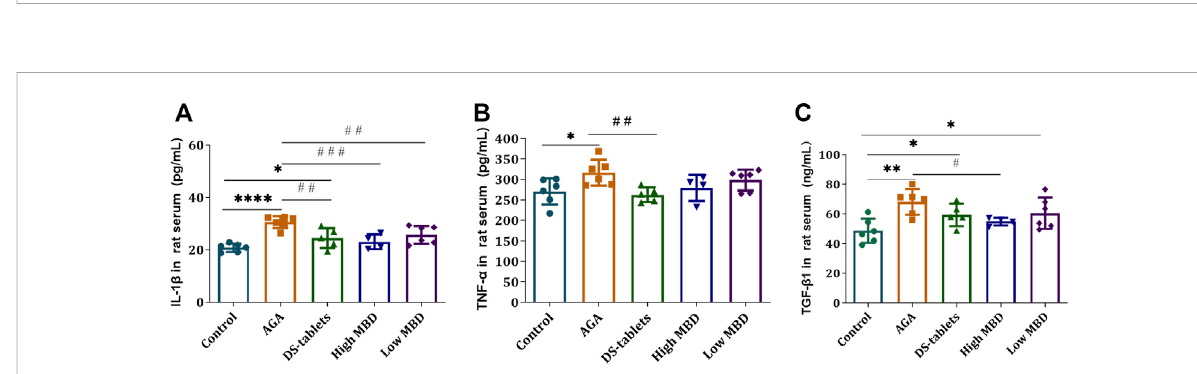
FIGURE 5 Effect of MBD on IL-1 β , TNF- α and TGF- β 1 expression levels in the serum of gouty arthritis rats. (A) IL-1 β . (B) TNF- α . (C) TGF- β 1. *p < 0.05, ** p < 0.01, *** p < 0.001 indicate that the difference was statistically signi fi cant compared with the control group. # p < 0.05, ## p < 0.01, ### p < 0.001 compared with the AGA group, the difference was statistically signi fi